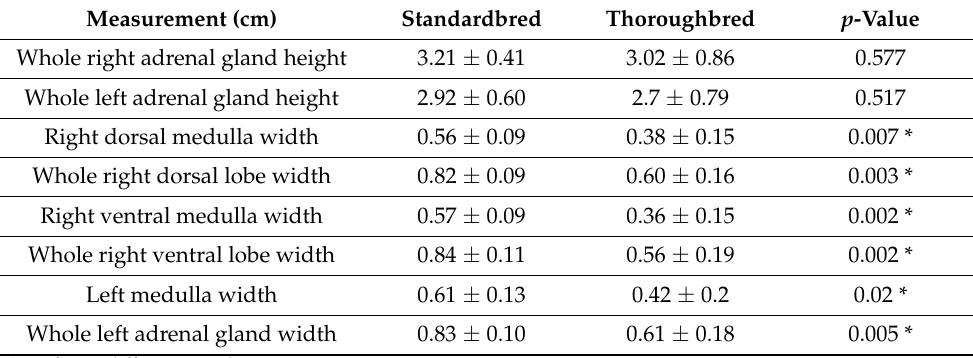
Table 1. Objective ultrasonographic measurements of adrenal glands, aorta and caudal cava vein in healthy neonatal Standardbred ( n = 10) and Thoroughbred ( n = 10) foals ( ≤ 72 h). Results are expressed as the mean value and standard deviation. Measurement (cm) Standardbred p